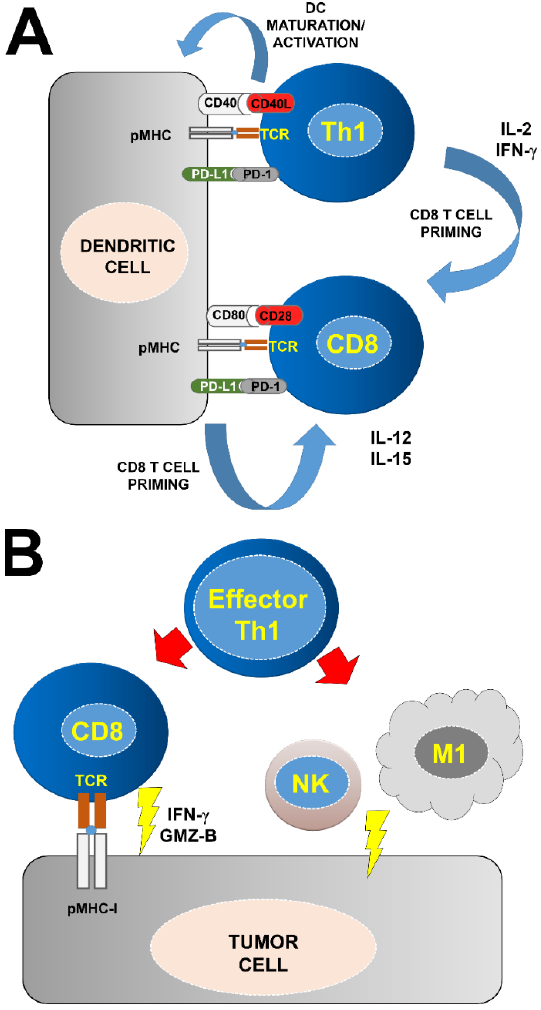
Figure 3. Role of CD4 Th1 cells in anti-tumor immunity. The best characterized mechanisms by which CD4 Th1 cells exert in anti-tumor responses are schematically shown in the figure. ( A ) Dendritic cells present antigenic peptides complexed to MHC molecules (pMHC) on their surface to both CD4 Th1 cells (top) and naïve CD8 T cells (bottom). CD4 Th1 cells participate in the appropriate priming of CD8 T cells by enhancing dendritic cell maturation and activating CD8 T cells through cytokine priming. The main co-stimulatory interactions are shown for CD4 and CD8 T cells. PD-L1 binding to PD-1 on the T cell surface is shown. This interaction also takes place during physiological antigen presentation, and it regulates ligand-induced TCR down-modulation. These processes are termed DC and CD8 licensing. ( B ) In a second step, CD8 CTLs infiltrate tumors and attack tumor cells after TAA recognition through a variety of mechanisms. The production of IFNs and granzyme are shown just for illustration. Tumor-infiltrating Th1 cells can directly activate NK and M1-macrophages enhancing their innate anti-tumor responses. NK cells can directly lyse tumor cells, and antigens can be picked up by M1 macrophages, which further enhance antigen presentation and activation of CD8 T